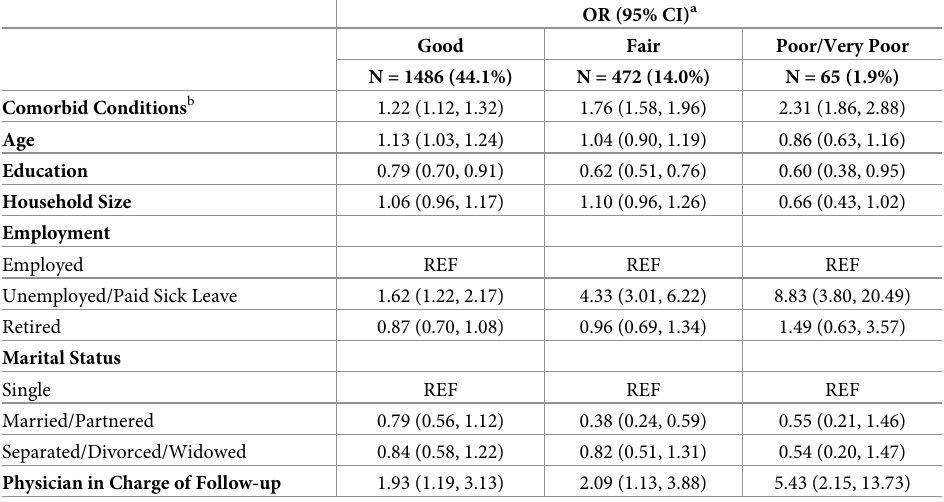
Table 2. Association between the number of comorbid conditions and quality of life among breast cancer survi- vors in the Transitions Study using multinomial logistic regression.